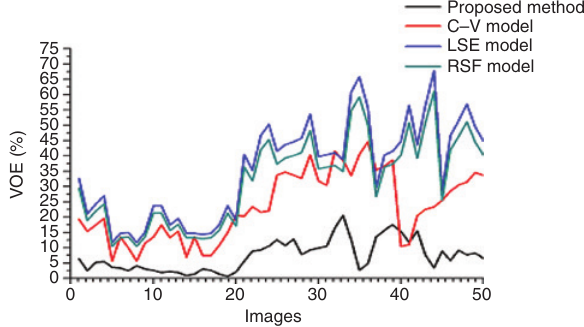
Figure 7: Comparison of Results Using VOE for CT Scan Images.